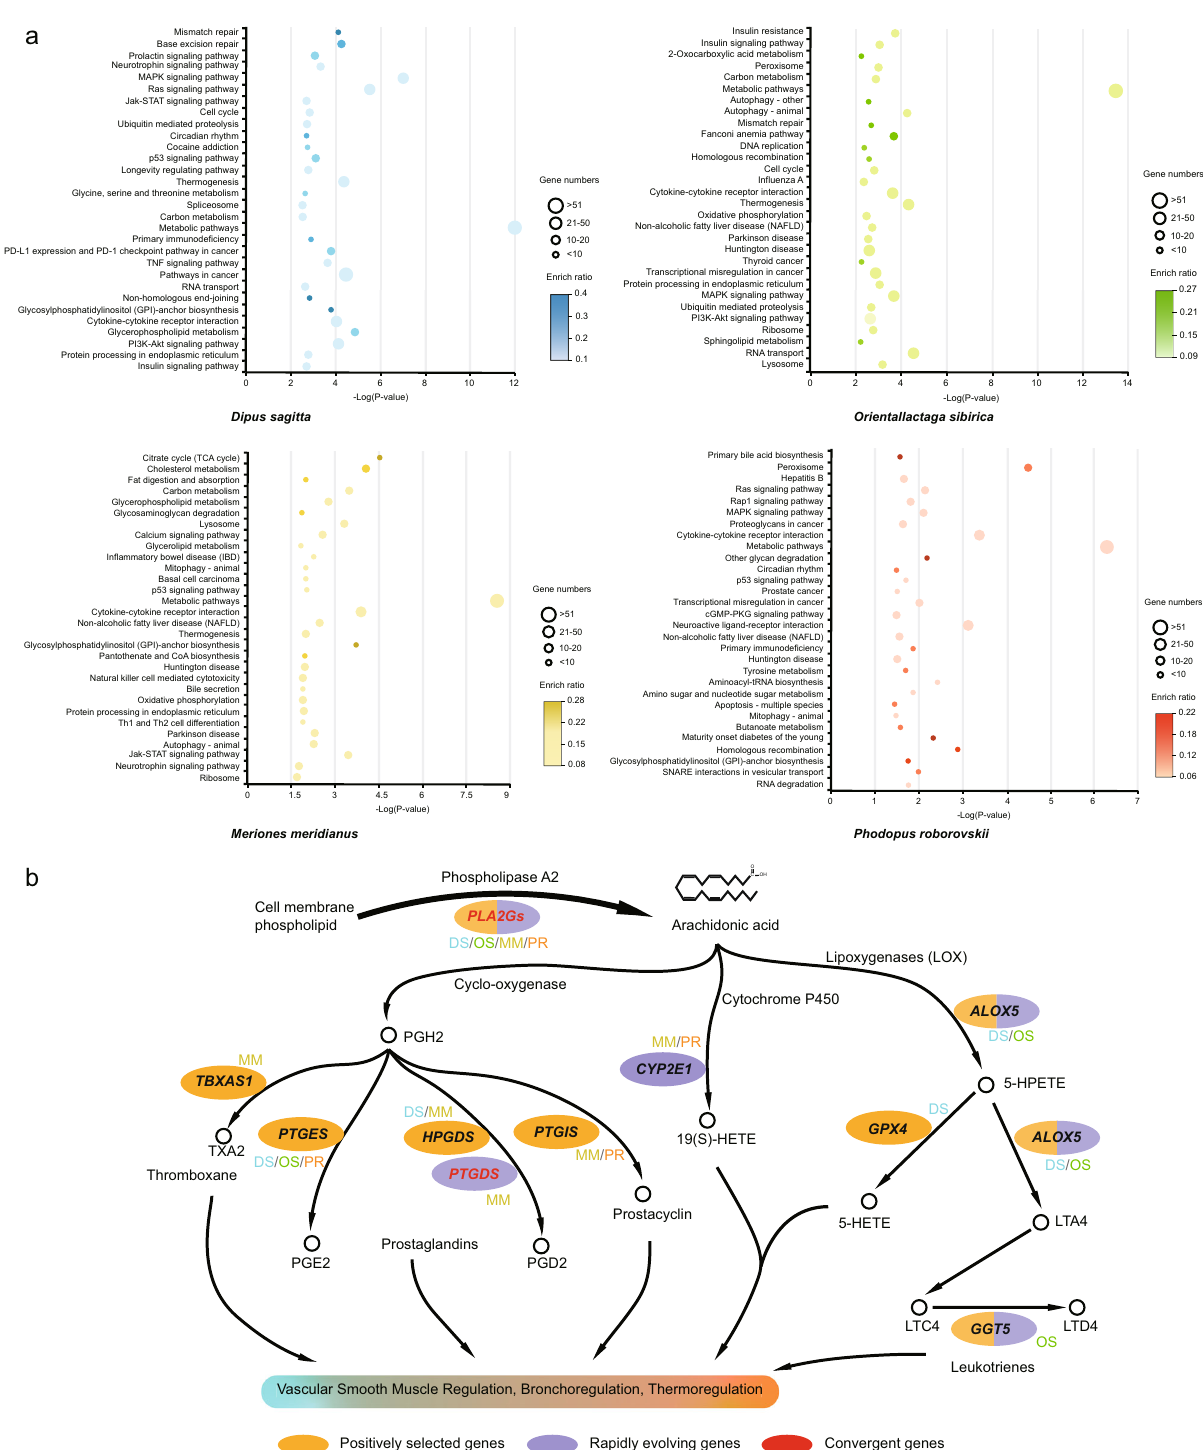
Fig. 3 The enriched KEGG pathways and diagram of arachidonic acid metabolism pathway evolution in the four desert rodents, Dipus sagitta (DS), Orientallactaga sibirica (OS), Meriones meridianus (MM), and Phodopus roborovskii (PR). a The enriched KEGG pathways of combined positively selected genes (PSGs) and rapidly evolving genes (REGs) in the four desert rodents. The x axis shows the -Log ( P -value) of PSGs and REGs in each pathway. The size of the dot indicates the number of genes. The depth of dot color indicates the enrich ratio. b Alterations in the arachidonic acid metabolism pathway of the four desert rodents. Genes in yellow background are PSGs, genes in violet background are REGs, and red genes are under convergent evolution. The symbol next to the gene indicates the species in which the gene has